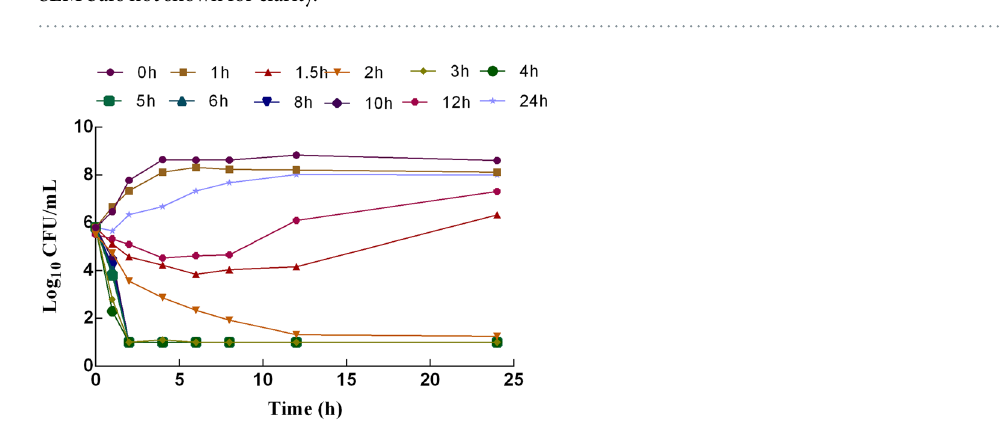
Figure 3. In vitro killing curves of cyadox against C . perfringens CPFK 122995 in brucella broth (mean, n = 3). SEM bars not shown for clarity.